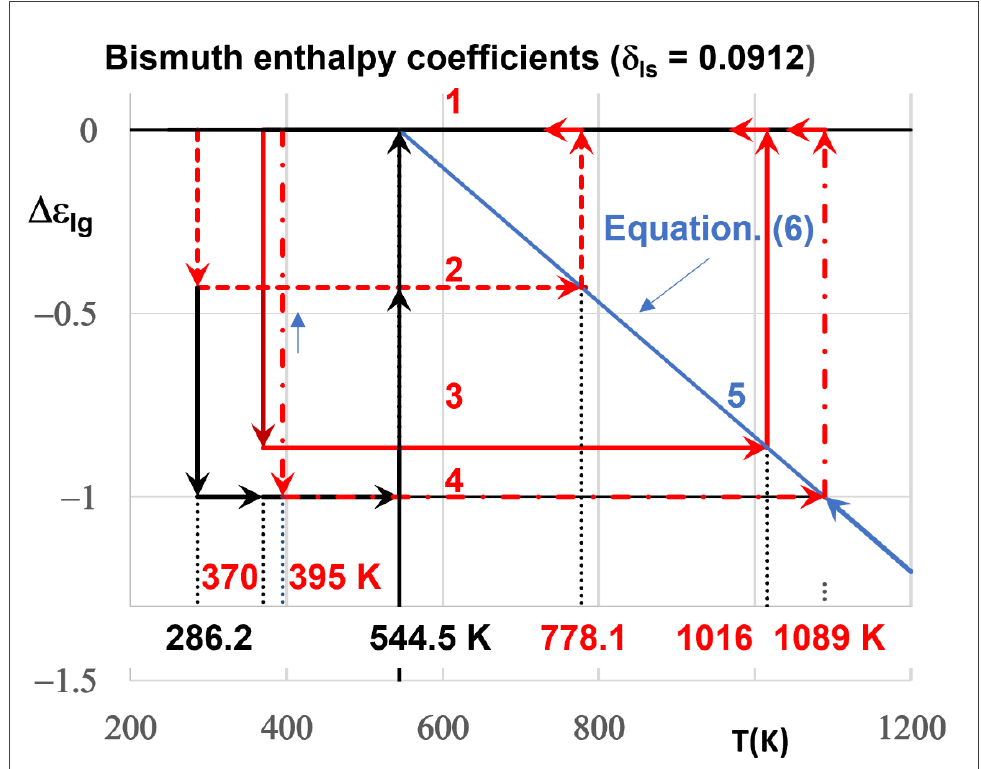
Figure 2. Bismuth glassy phase fractions f = Δε expected after undercooling and reheating. Four liquid – liquid transitions at T n+ = T g after reheating were observed. Horizontal lines: 1 —Δε lg = 0 of glassy fractions; 2 —Δε = θ n+ = θ g = 0.42908 up to T g = 778 K, 0.43838 up to T g = 783 K, (not represented); 3 —Δε= 0.8675 up to T g = 1016 K; 4 —Δε = 1 up to T g = 1089 K without crystallization at T m . Vertical lines: T x = 286.2 K leading to Δε = 0.42908 and a crystallized fraction (1 – Δε = 0.057092); T x = 370 K leading to Δε = 0.8675 and a crystallized fraction (1 – Δε = 0.1325); T x = 395 K leading to Δε = 1; T m = 544.5 K: melting of crystallized fractions; T n+ = 778.1 K; T n+ = 1016 K; T n+ = T g = 2; T m = 1089 K. The glass transitions leading to Δε lg = 0 would be observed by reversing heating to cooling slightly below T g . Line (5) represents Equation (6).